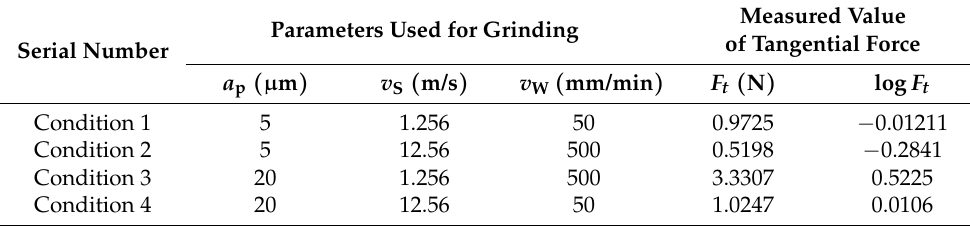
Table 8. Grinding force test data for end-common